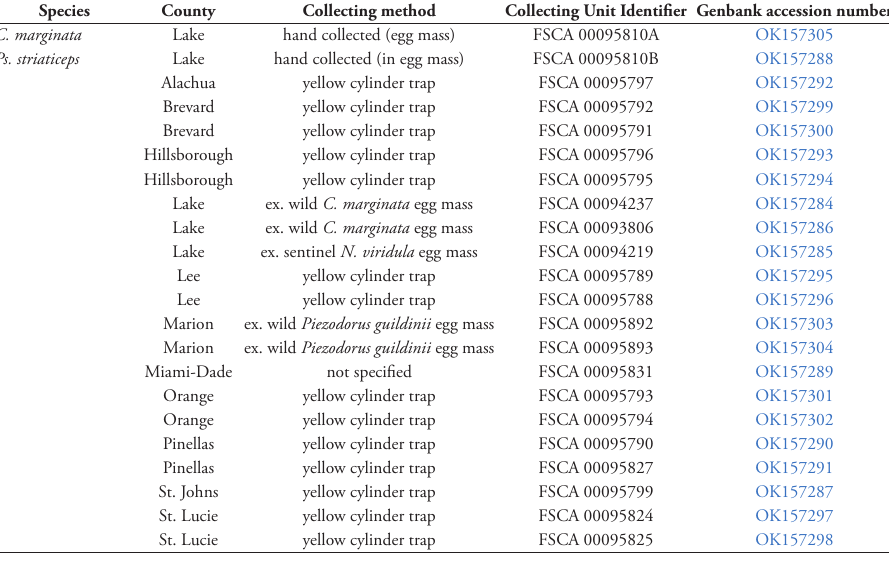
Table 1. Locality data, collection method, collecting unit identifiers, and GenBank accession numbers for P. striaticeps and C. marginata collected in Florida.